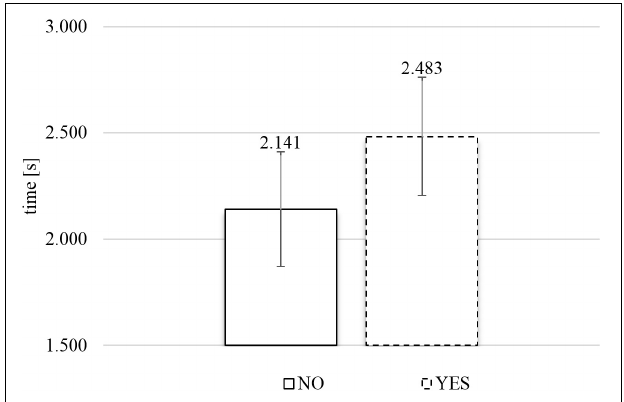
FIGURE 4 | Average exposure time of food images rated from 1 (“not like at all”) to 5 (“like very much”) in the time-controlled non-exclusive evaluation ( N = 78). Error bars reflect the 95% confidence interval around the mean.